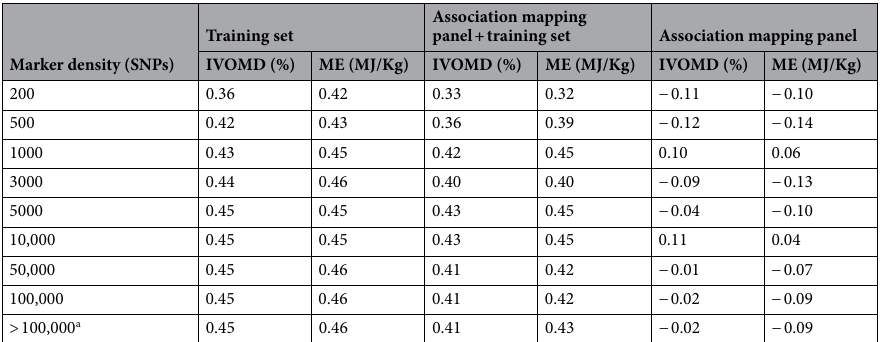
Table 3. Prediction accuracy as determined by Pearson’s coefficient between predicted value estimated at different marker density (sampled 20 times) and the observed phenotype using the training set of advanced related breeding lines and the association mapping panel. a Sampled only one time with the total SNP markers (156,884 SNPs for testing set and 127,623 SNPs for Association mapping panel + Training set).